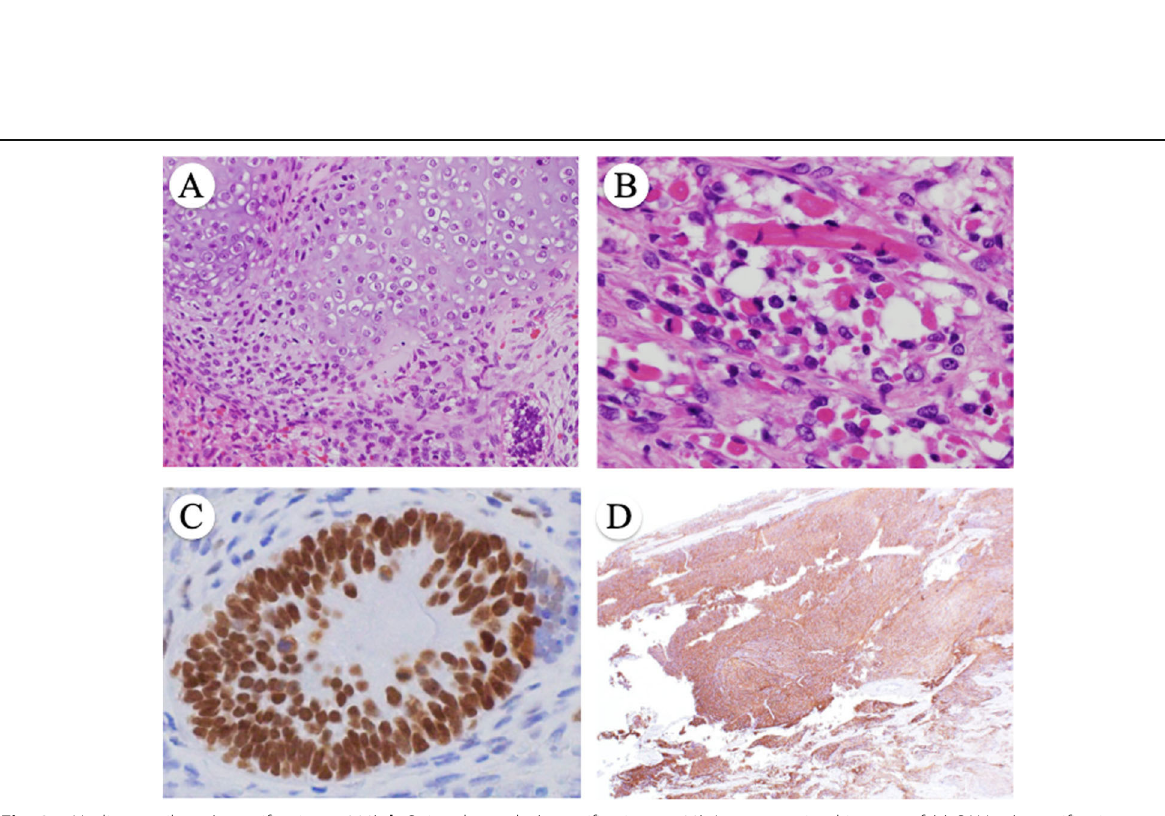
Fig. 3 a Hyaline cartilage (magnification × 200). b Striated muscle (magnification × 400). Immunostained images of ( c ) SALL4 (magnification × 400) and ( d ) synaptophysin (magnification ×